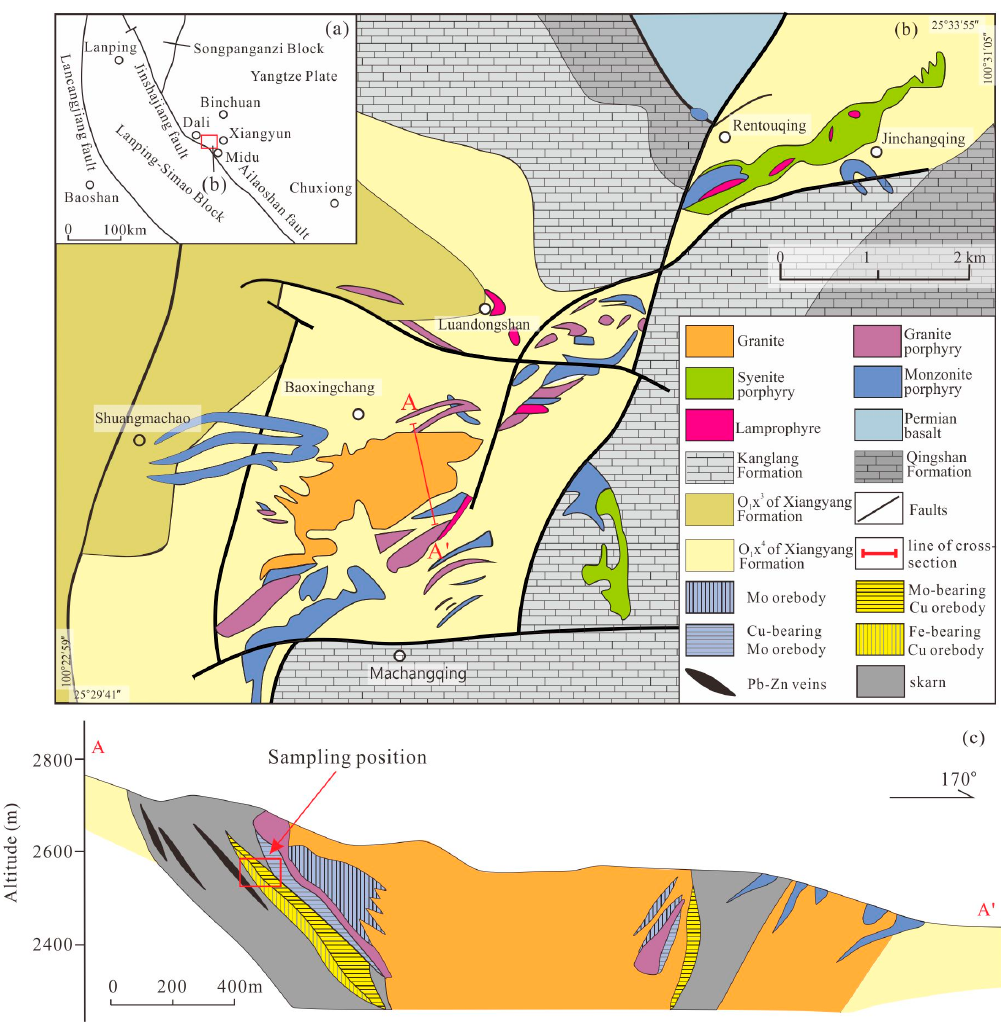
Figure 3. Geological map ( a , b ) and cross-section ( c ) of the Machangqing deposit. Modified after [30,45].